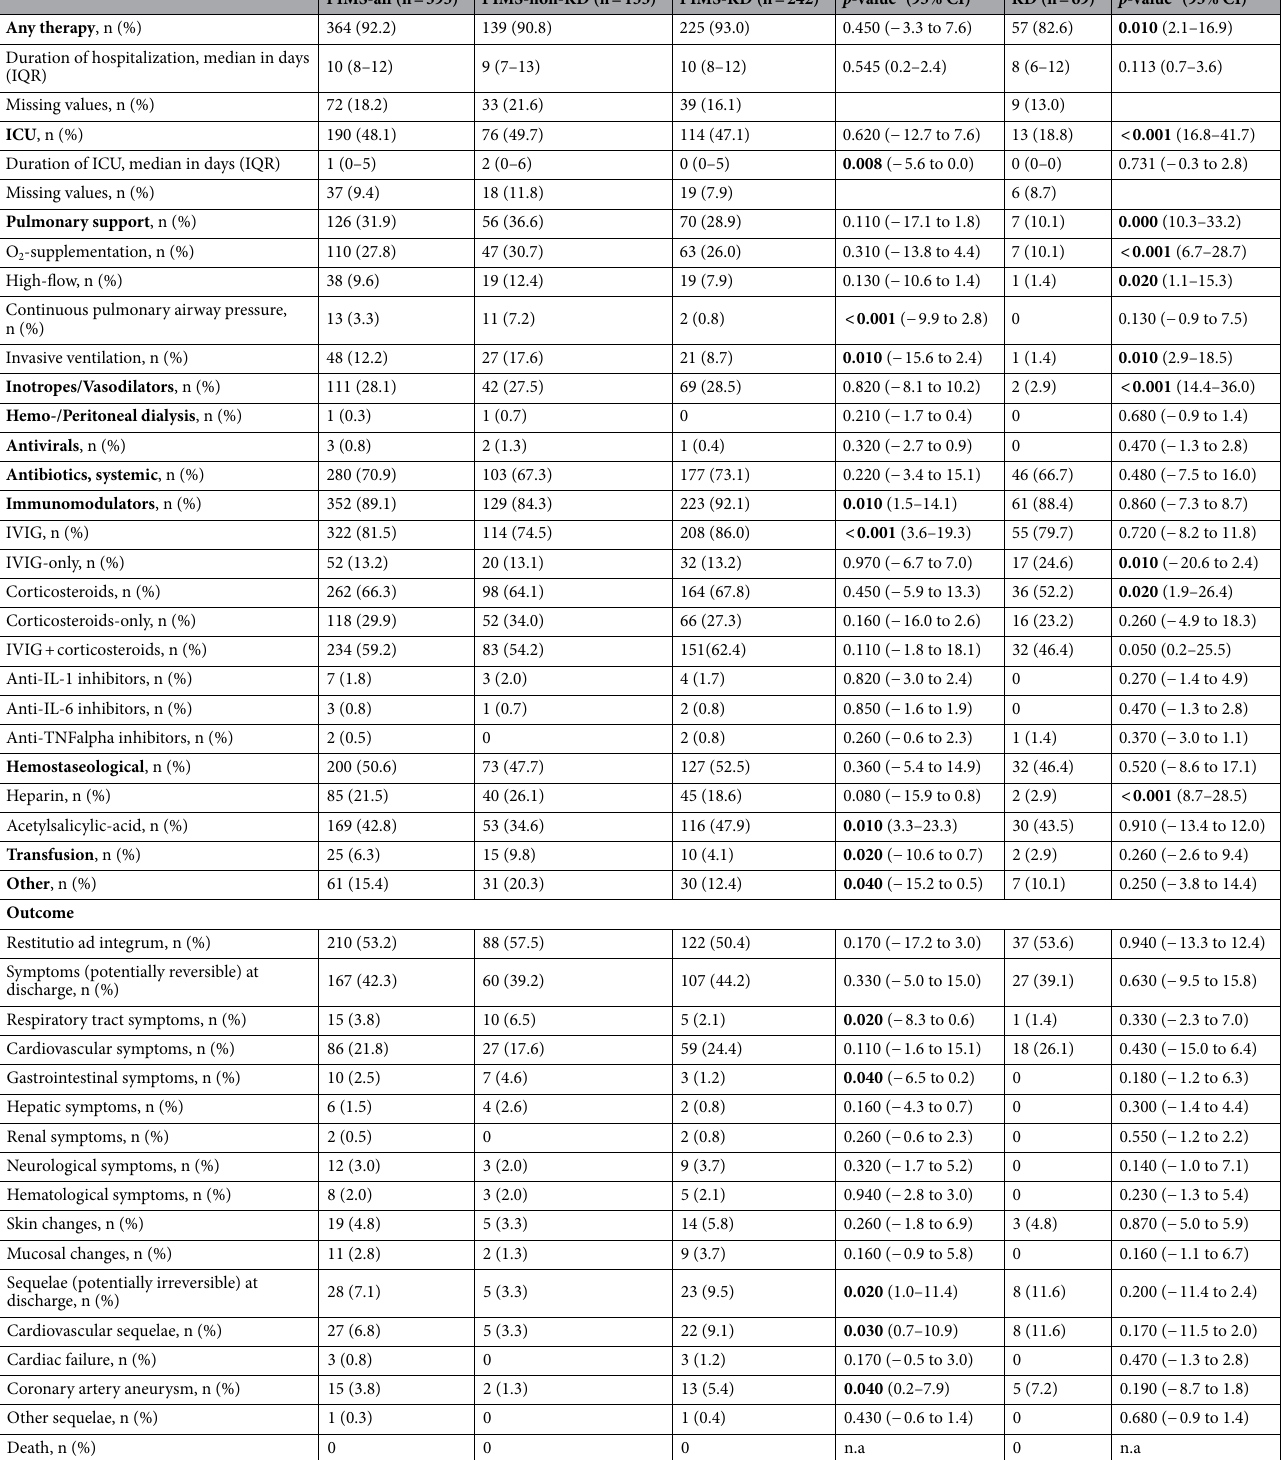
Table 3. Therapy and outcome in patients with PIMS-all, PIMS-non-KD, PIMS-KD and KD. PIMS, Pediatric Multisystem Inflammatory Syndrome; KD, Kawasaki disease. a comparison between PIMS-non-KD